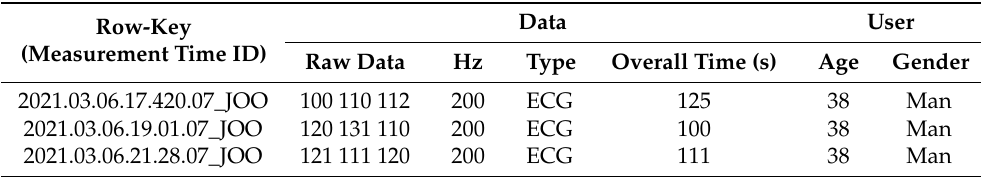
Table 1. HBase table